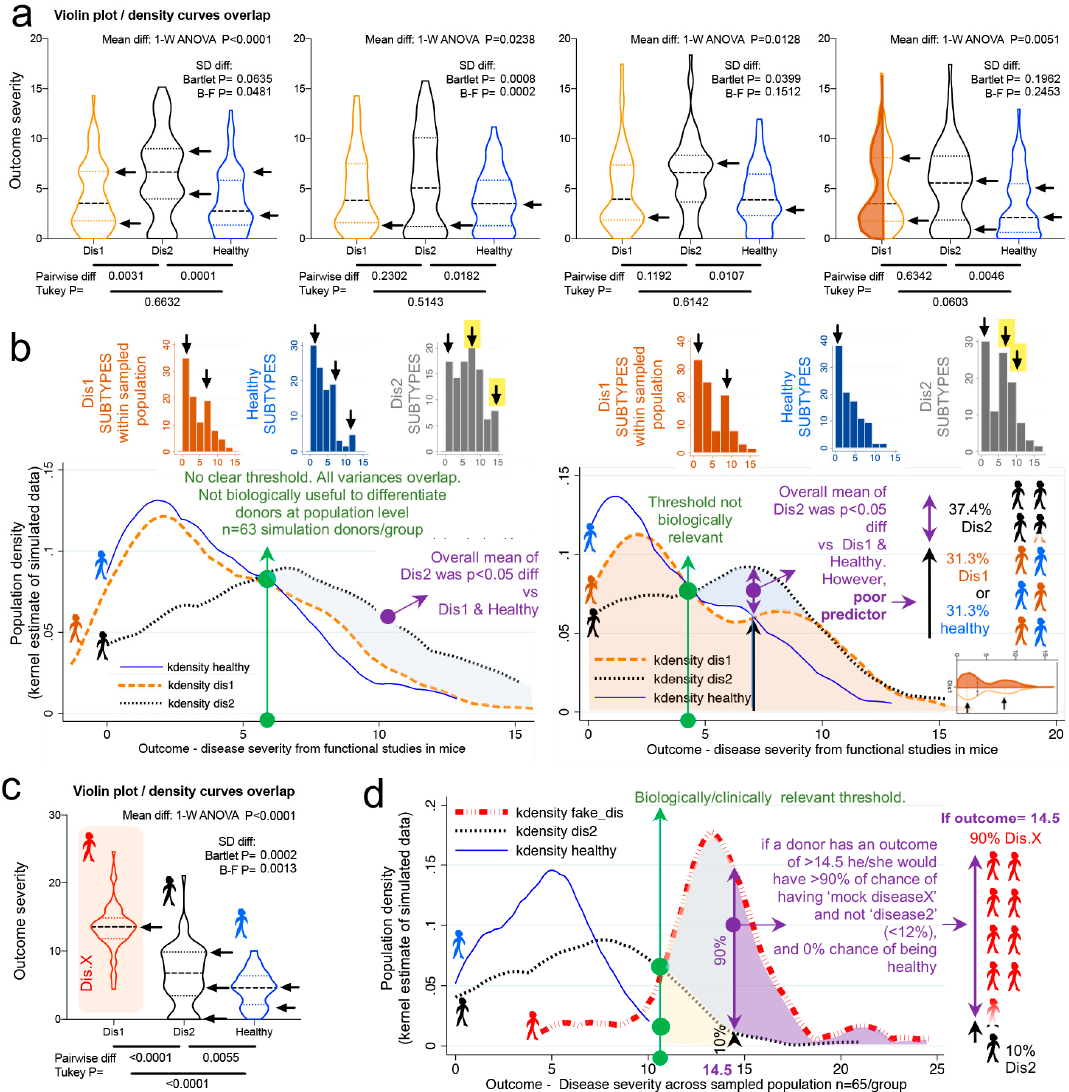
Figure 3. Violin plots illustrate that statistical differences with large N may not have clinical predictive value at individual level. Violin and kernel plots illustrate statistical vs. biologically relevant differences and thresholds. ( a ) Violin plots of four simulated random number sets illustrate that each set of donors may have unique subtypes of disease illustrated with arrowheads (disease severity scores with higher number of simulated donors). Arrows indicate “disease data subtypes” vary with every simulation of 63 donors/group. ( b ) Kernel density curves illustrate large overlap of sample population from simulated data (see panel 3a). Significant differences are highlighted by shaded area. Note the threshold does not have distinctive separation for the plots indicating that it is not biologically useful as a predictor of outcome. ( c ) Violin plots illustrate meaningful statistical difference for population (compared to panel 3b). “Fake disease X” (“DisX”) was generated as a “mock” disease following Gaussian distribution around the mean. Monte Carlo simulations were significant 96.5% (upper limit 97.6, lower limit 95.4%). ( d ) Kernel density curves of panel 3c illustrate example of distribution separation with both statistical difference and biological relevance.